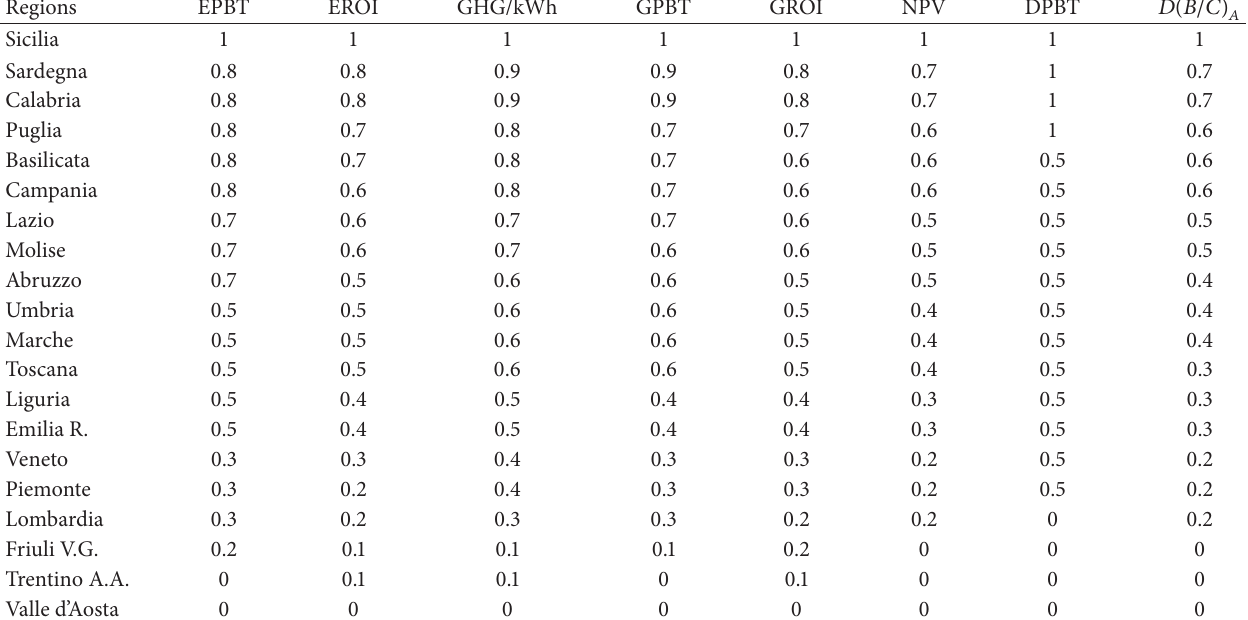
Table 2: Economic, energetic, and environmental normalized